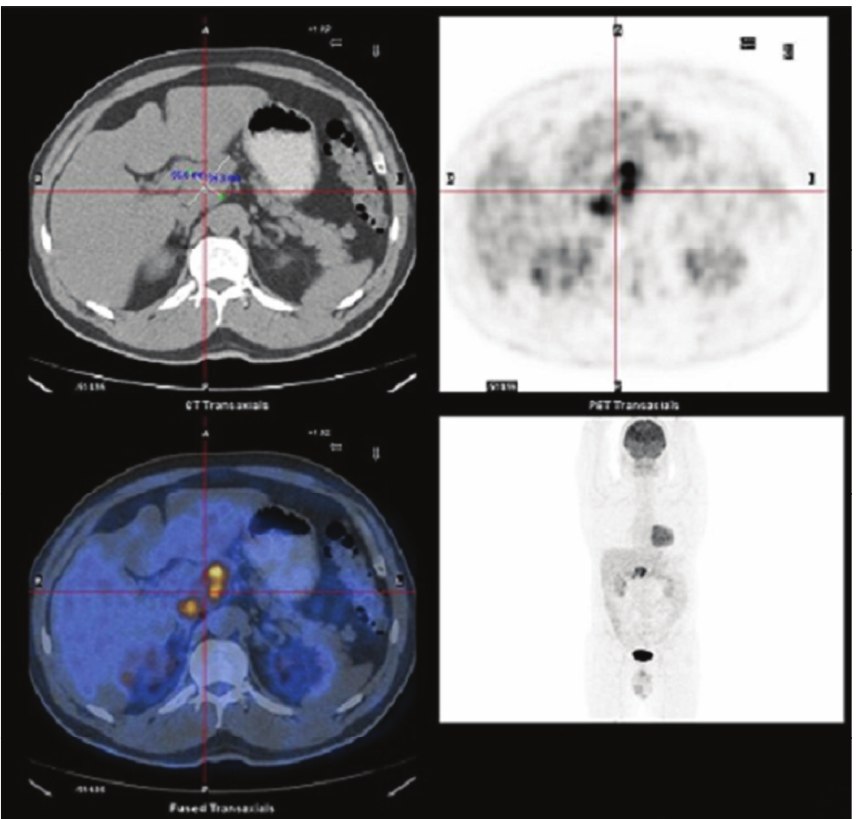
Figure 2: Axial and coronary images of 18 F-FDG CT-PET. Upper and low left pictures represent plane CT and PET fusion image, respectively. Metabolically active lesion (yellow-red) located in the upper abdomen below the liver with high avidity to 18 F-FDG on CT-PET fusion image (lower